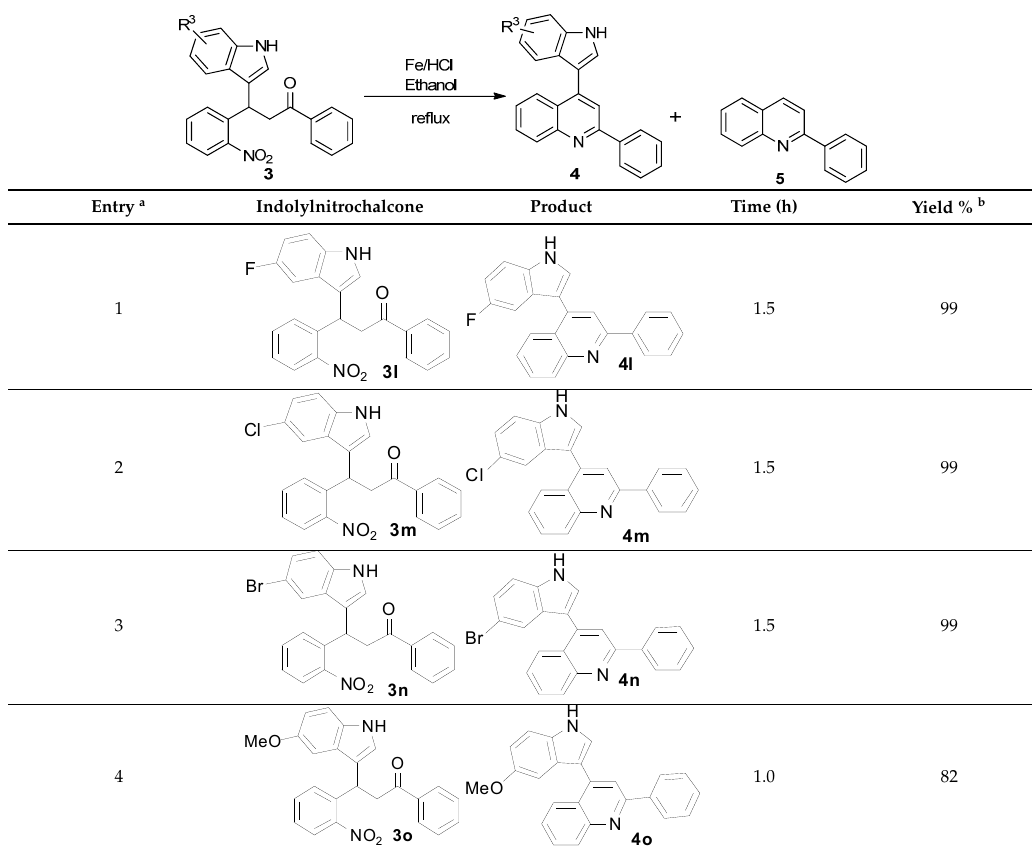
Table 5. Reductive cyclization of 3-(1 H -indol-3-yl)-3-(2-nitrophenyl)-1-phenylpropan-1-one derivatives derived from various indoles and 2-nitrochalcone.